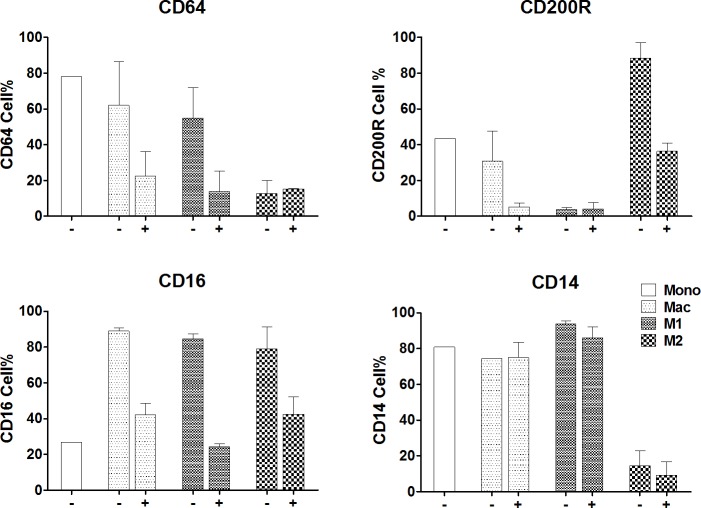
MGBG inhibited polarization of monocytes into M1 and M2 macrophages.Isolated human monocytes were cultured to differentiate and induced to M1 or M2 macrophages using 50 ng/ml INF-γ and 1 μg/ml LPS or 50 ng/ml IL4 for 5–6 days with or without 0.4 μM MGBG. Cells were cultured and evaluated by flow cytometry at day 5 or 6. Mono: Baseline expression of cell surface markers in 4 hr cultured monocytes (% of all monocytes); Mac: Cultured in normal media -/+ 0.4 μM MGBG; M1: Cultured in M1 polarizing media -/+ 0.4 μM MGBG; M2: Cultured in M2 polarizing media -/+ 0.4 μM MGBG. MGBG inhibited monocyte differentiation in both M1 and M2 macrophages. n = 2.